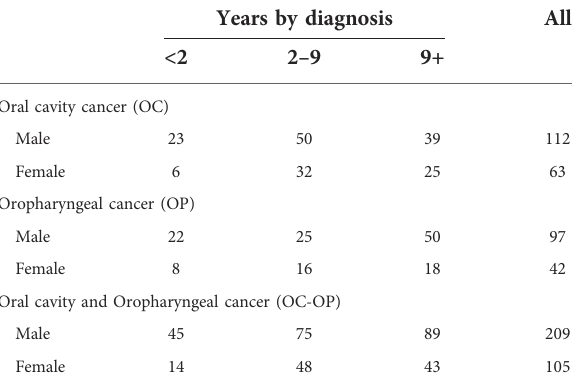
TABLE 4 Prevalence at fi rst January 2021 by subtype, sex and years by